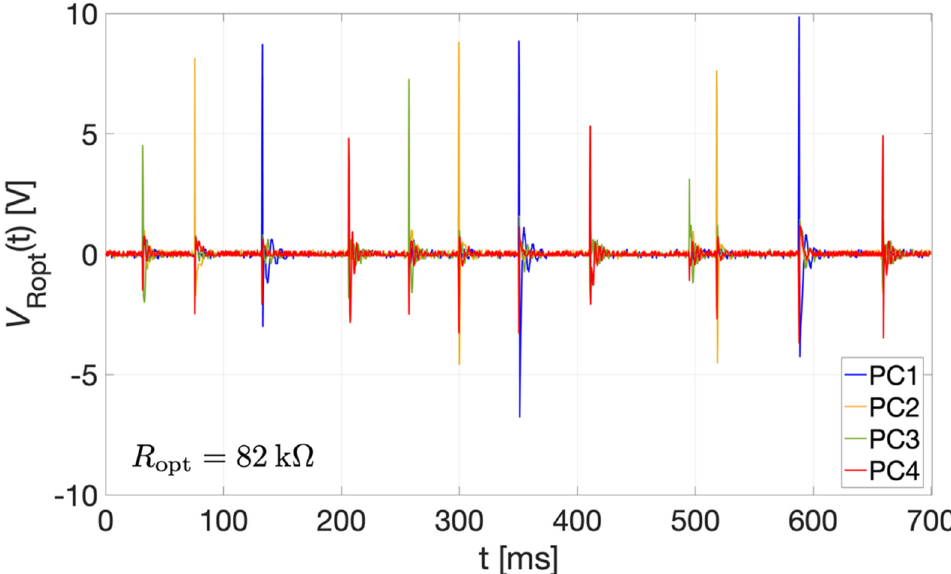
Figure 14. Measured voltages v Ropt (t) as a function of time with three different impacts happening against each PCs of the bi-axial harvester PC1, PC2, PC3, and PC4, reported with blue, yellow, green, and red curves, respectively.